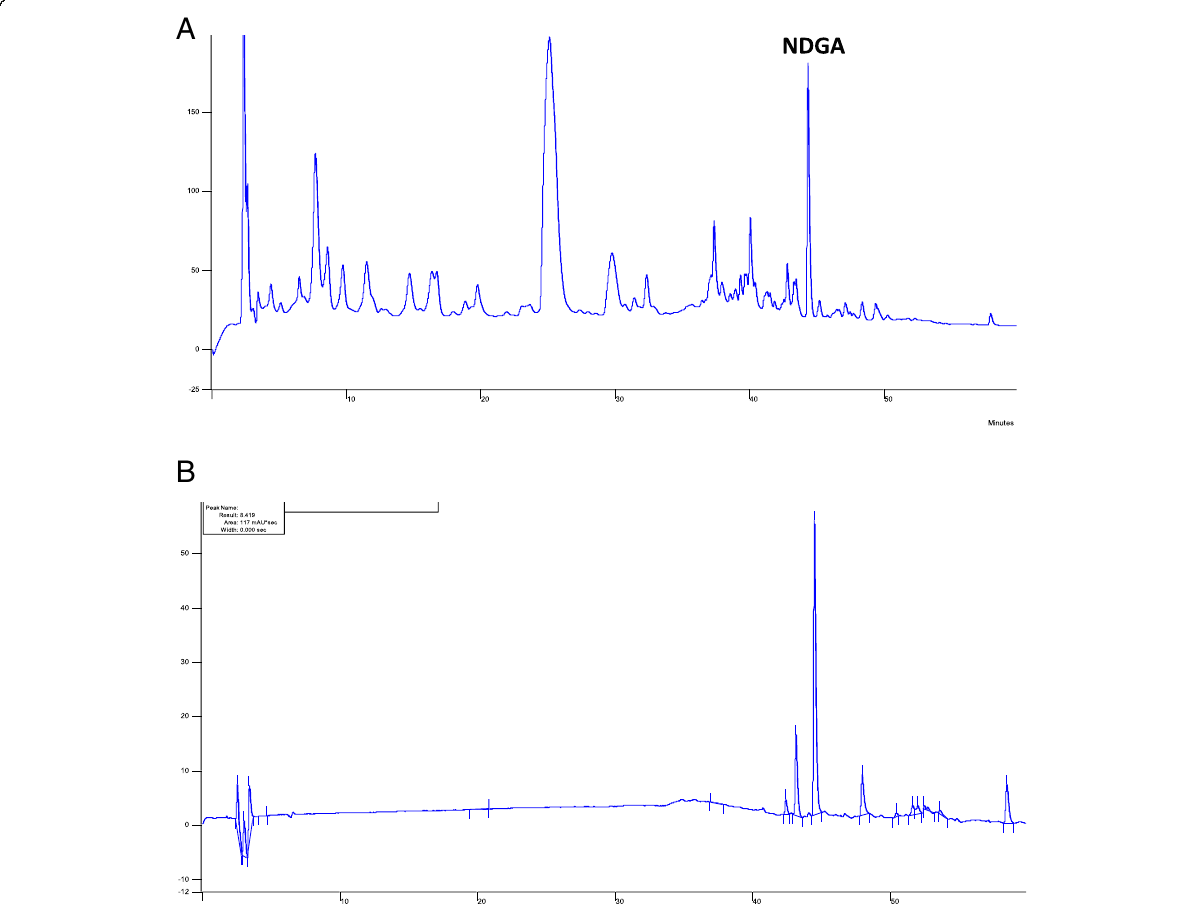
Fig. 1 HPLC analysis of the AE obtained from L. divaricata Cav. a : Chromatographic profile of AE, and ( b ): Chromatographic profile of the NDGA